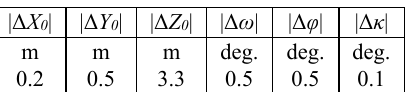
Table 2. Absolute differences between the computed and the reference EO parameters of the starting